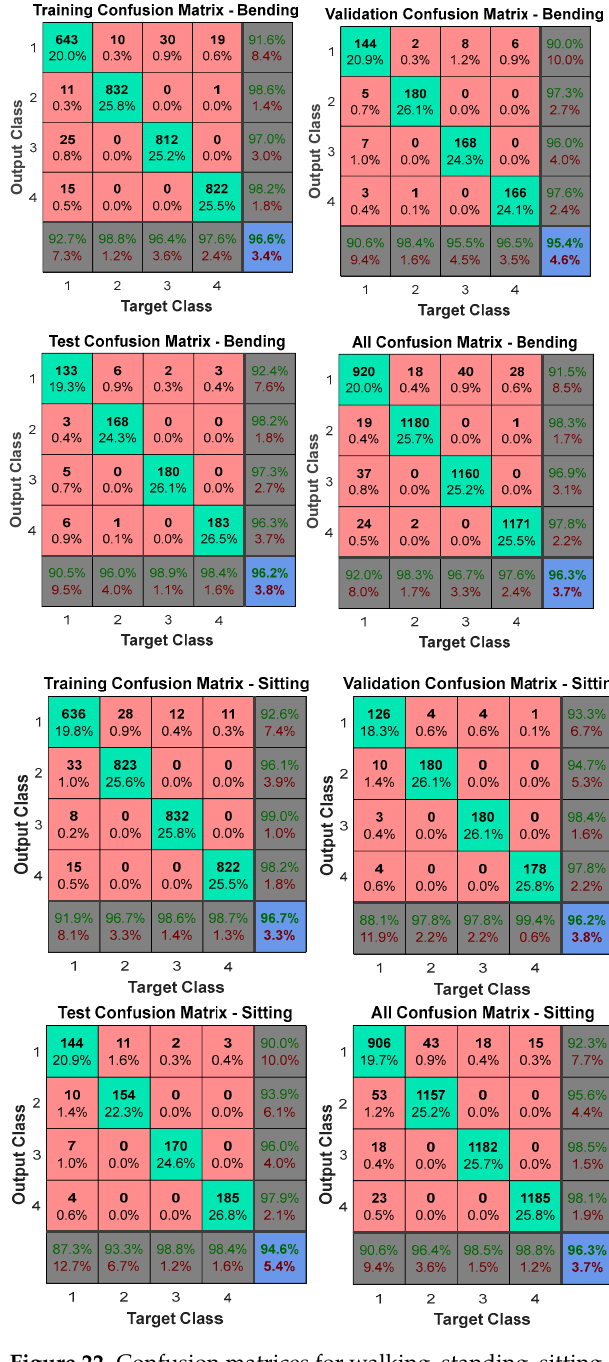
Figure 22. Confusion matrices for walking, standing, sitting, and bending activities.